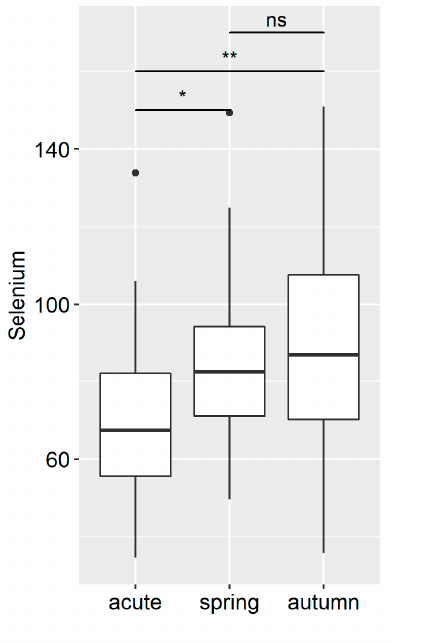
Figure 2. ( a ) MDA concentrations, μ mol/L, and ( b ) 4-HNE adducts concentrations, μ g/L, in blood plasma of acutely ill COVID-19 patients (acute) and in post-COVID-19 disease patients 2 months following their discharge from the hospital: infected with COVID-19 in the spring–early summer